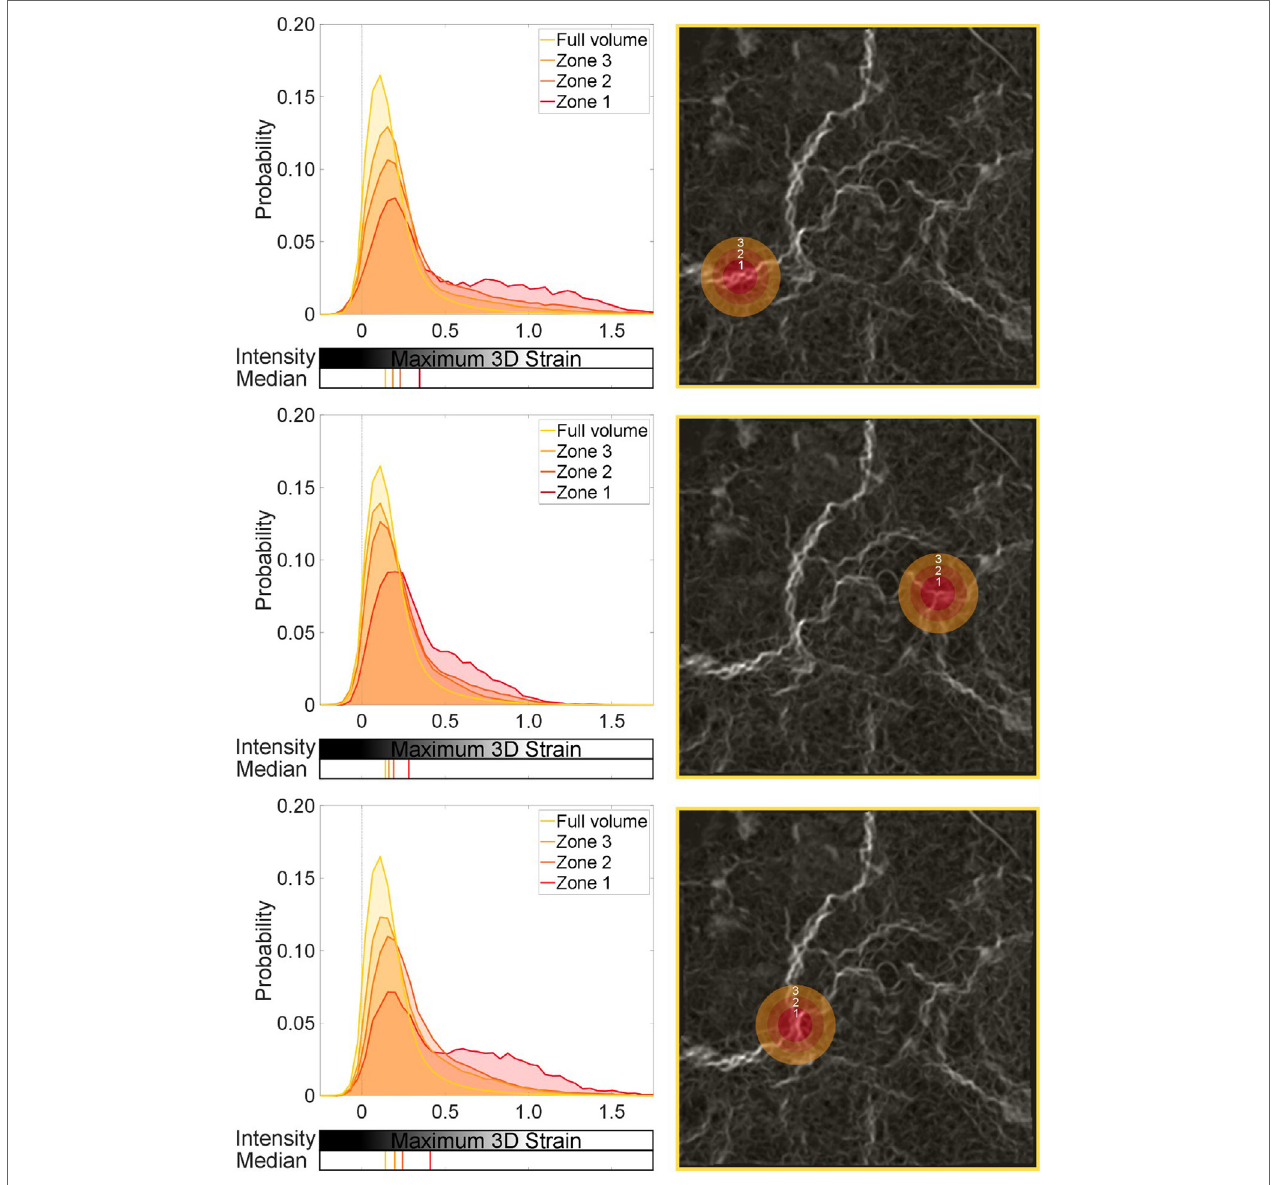
FigUre 9 | Global and local strain distributions around a strain concentration: moderate-level blast. Three regions are selected, with sequential spherical shell volumes analyzed to show the effect of the local strain discontinuity on the surrounding tissue. Zone 1 is the central sphere focused on a given strain concentration. Zones 2 and 3 are shells leading from Zone 1. The median for each distribution is also